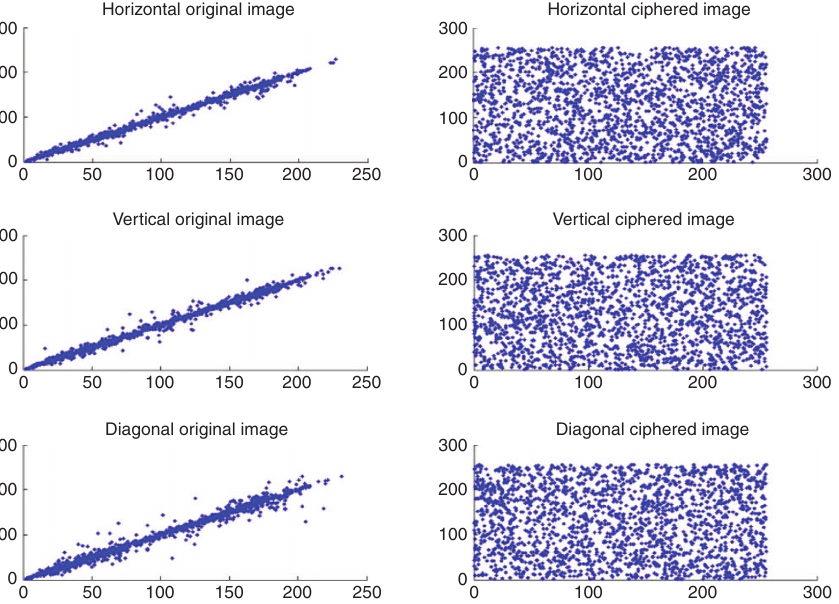
Figure 13: Plot Describes Correlation Horizontally, Vertically and Diagonally for Two Adjacent Pixels in Plain and Encrypted “Old Man”